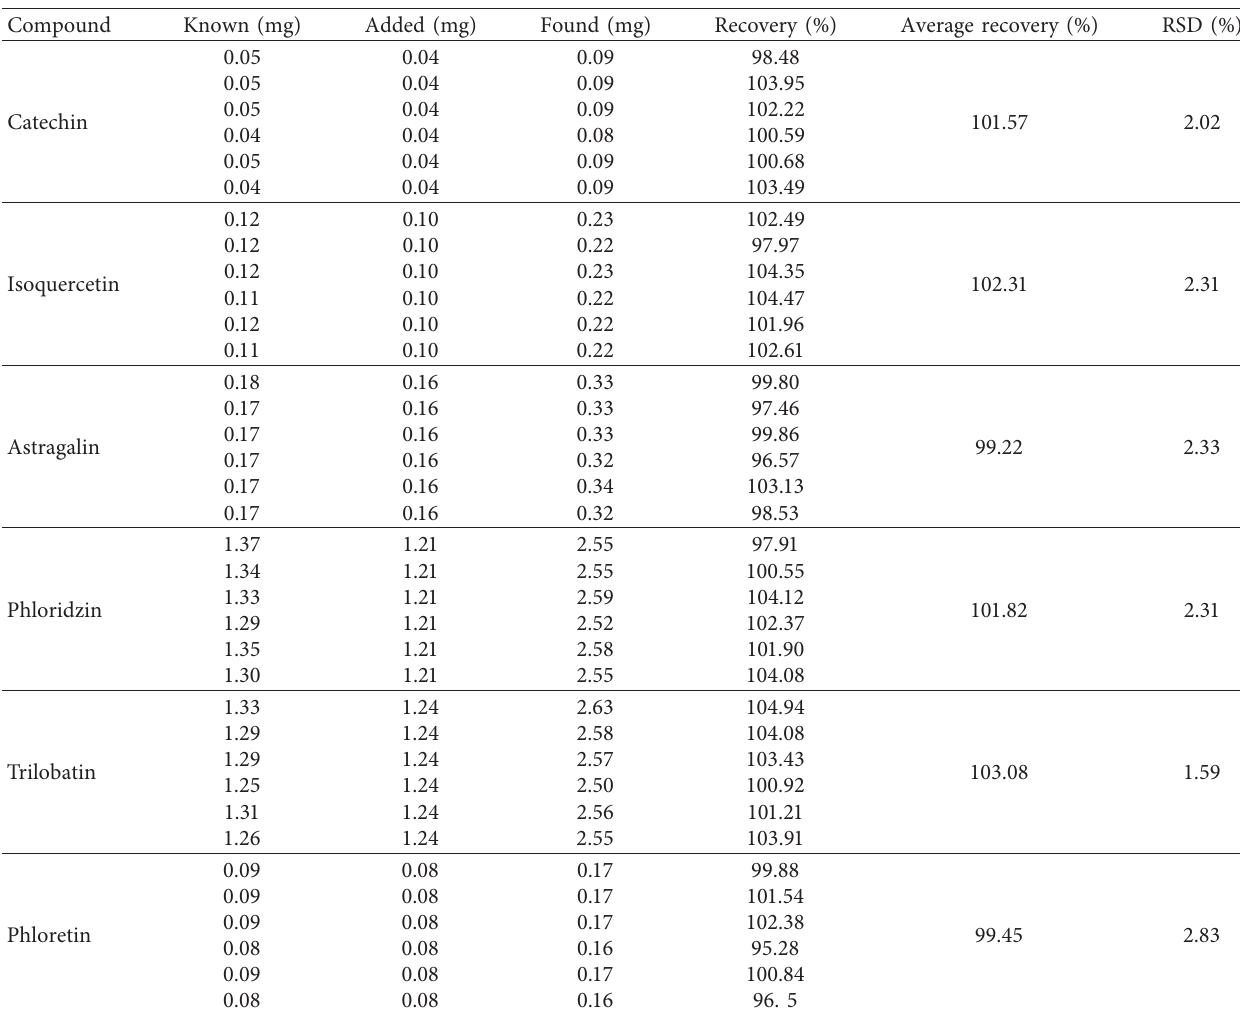
Table 3: Results of the recovery test.